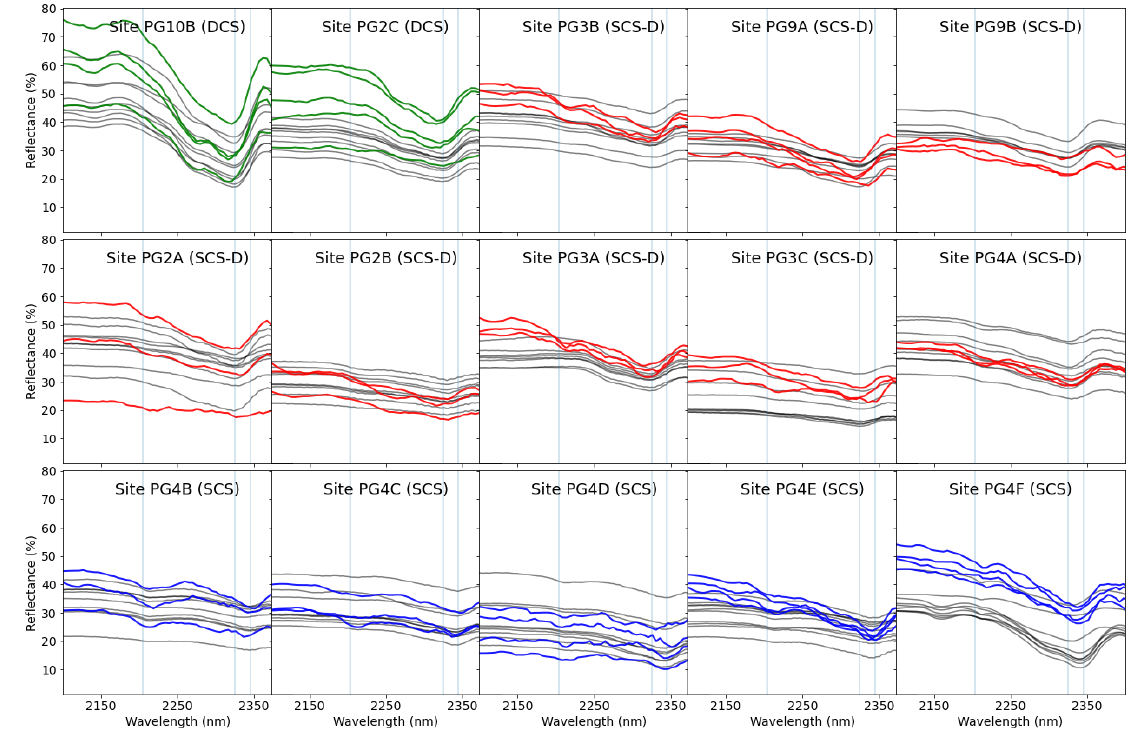
Figure 9. Comparison of corrected HySpex Mjolnir spectra and ground truth FieldSpec measurements (plotted in grey) from the Cassian Dolomite Formation (DCS; green), dolomitised San Cassiano Formation (SCS-D; red), and calcitic San Cassiano Formation (SCS; blue). The location of these validation sites is plotted in Figures 4 and 11. Note that these measurements were used to check the spectral accuracy of the UAV data, not to validate a classification or lithological map of the outcrop; so lithological unit labels provided above are for reference only. Blue vertical lines show the expected positions of the AlOH, dolomitic CO 3 and calcitic CO 3 absorption features mapped in Figures 11 and 12.